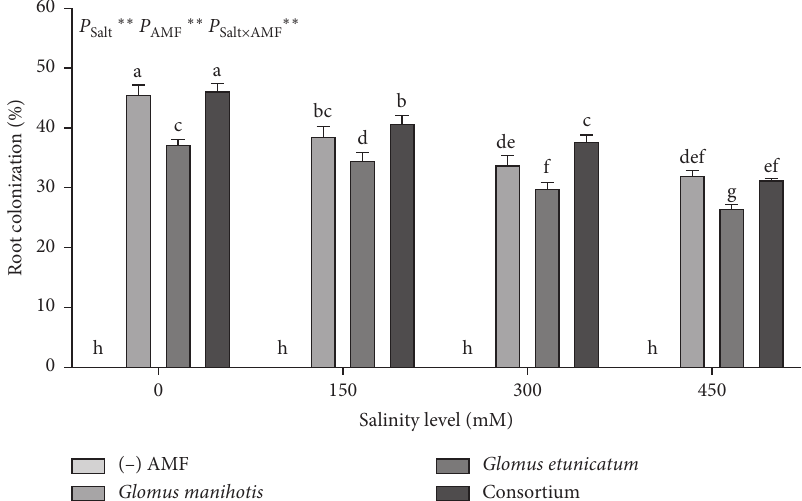
Figure 8: Examples of AMF structures as indicators of L. leucocephala colonization. A. Dissected root of L. leucocephala observed at 4x showing (a) external hyphae of AMF; B. Internal root tissue of L. leucocephala stained with trypan blue showing (a) hyphae and (b) vesicle observed at 400x; C. Root cell containing an (c) arbuscule observed at 1000x.